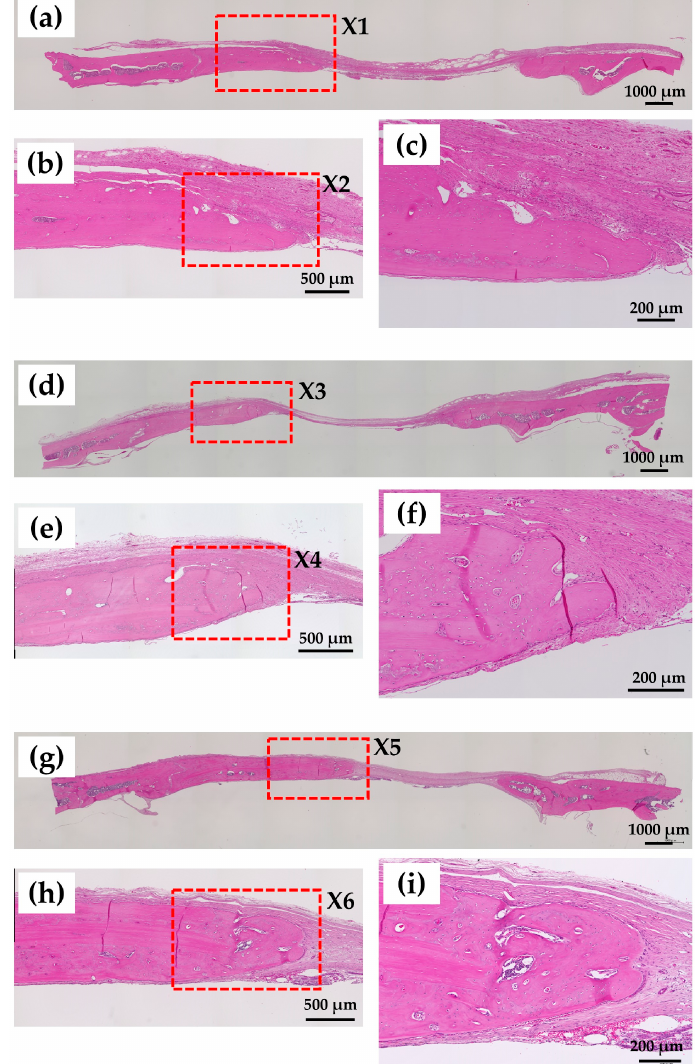
Figure 10. Hematoxylin and Eosin (HE)-stained histological images of rat cranial bone defects 8 weeks after the operation with and without construct materials including ( a – c ) defect only, ( d – f ) defect with BMP ( − ) construct (i.e., cHLA/cAG/nHAp) and ( g – i ) defect with BMP (+) construct (i.e., cHLA/cAG/nHAp/BMP). ( b ): enlarged from X1 in ( a ,). ( c ): enlarged from X2 in ( b ). ( e) : enlarged from X3 in ( d ). ( f ): enlarged from X4 in ( e ). ( h ): enlarged from X5 in ( g ). ( i ): enlarged from X6 in ( h ).